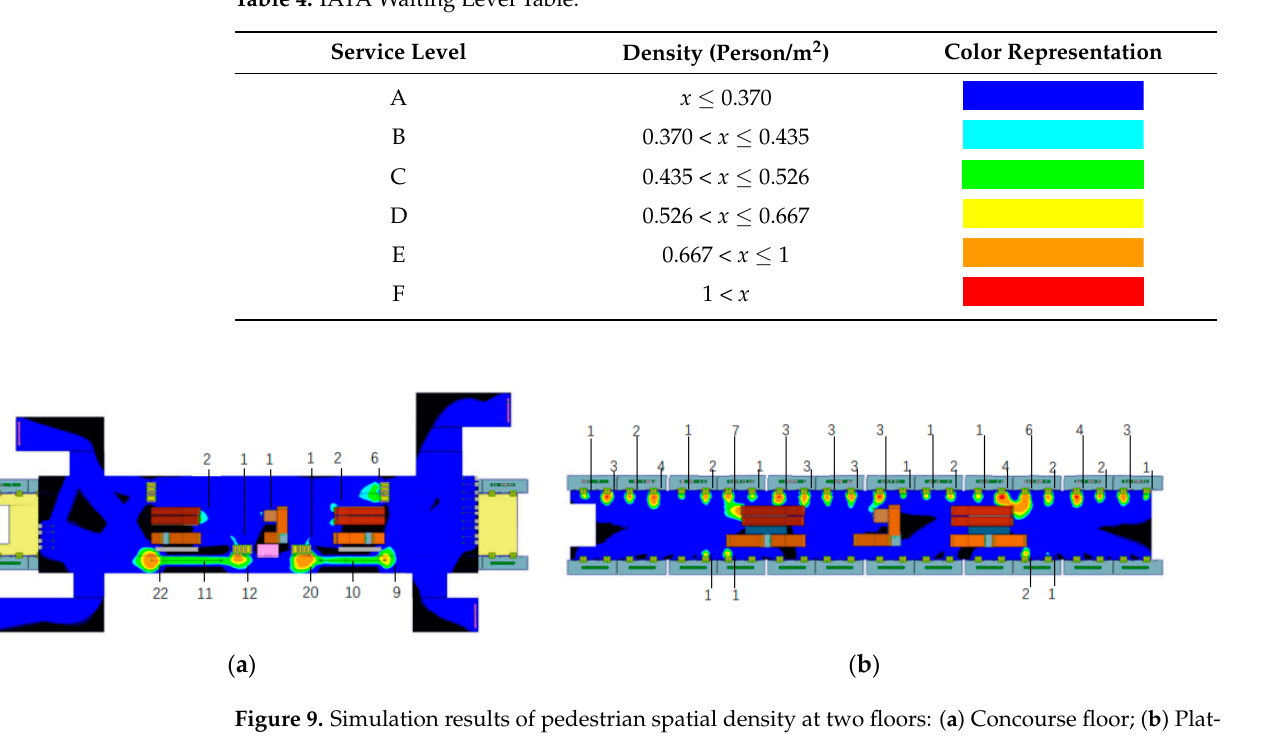
Figure 9. Simulation results of pedestrian spatial density at two floors: ( a ) Concourse floor; ( b ) Plat- form floor.